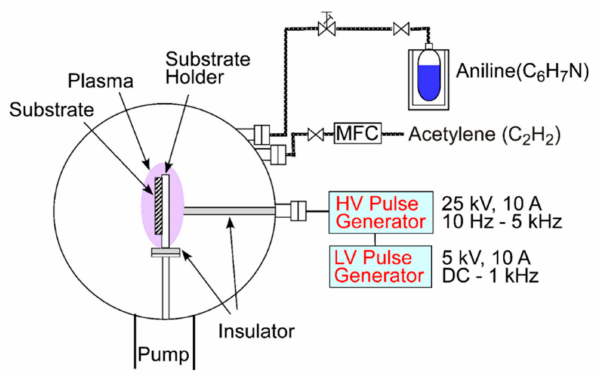
Figure 1. Schematic of the plasma source ion implantation (PSII) system used for the deposition.